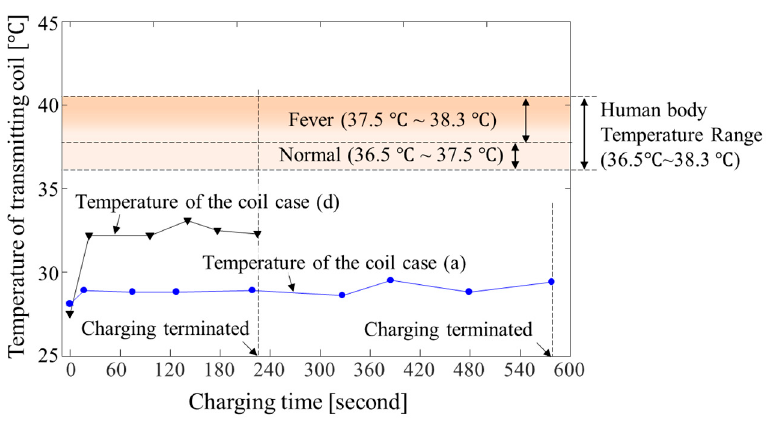
Figure 20. Measured temperature of the case (a) transmitting coil and case (d) transmitting coil under air media. Table 5. Comparison of the proposed design with related